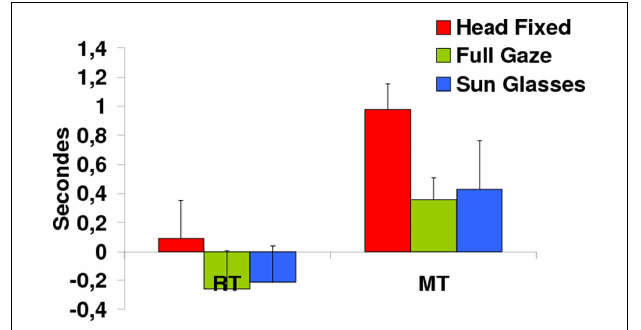
FIGURE 8 | Reaction time (RT) and movement (MT). RT is positive for Head Fixed, and negative (anticipatory) for Full Gaze and Sun Glasses, indicating that manipulator can read the iCub gaze.This anticipation is reflected in the movement time, as MT = RT + GT.